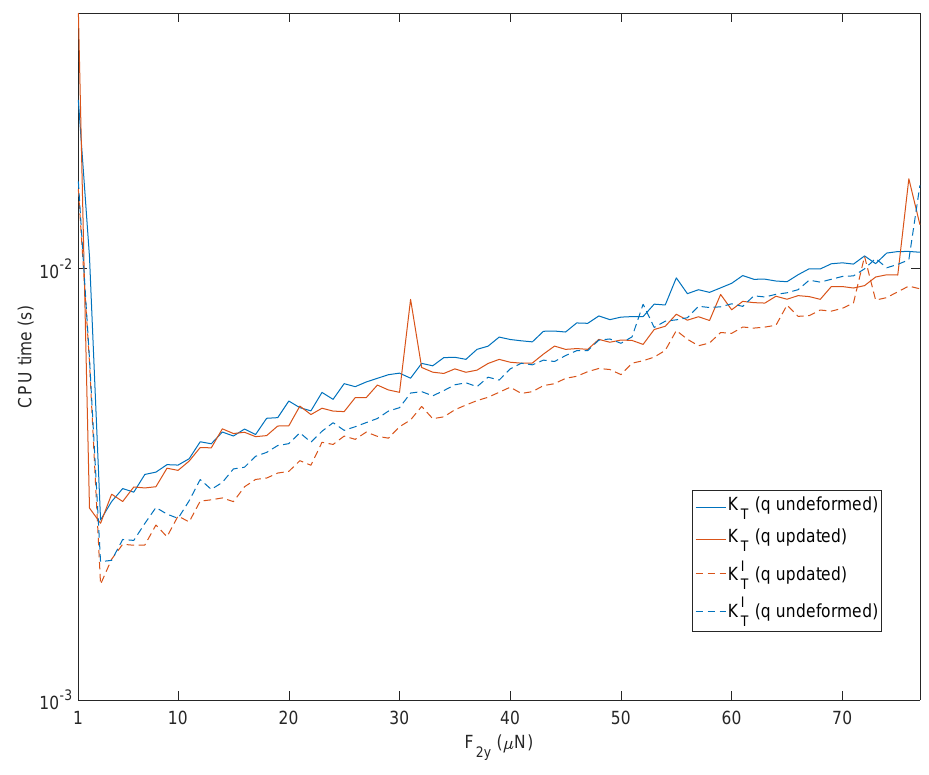
Figure 13. Computation time of the four strategies of Figure 12.